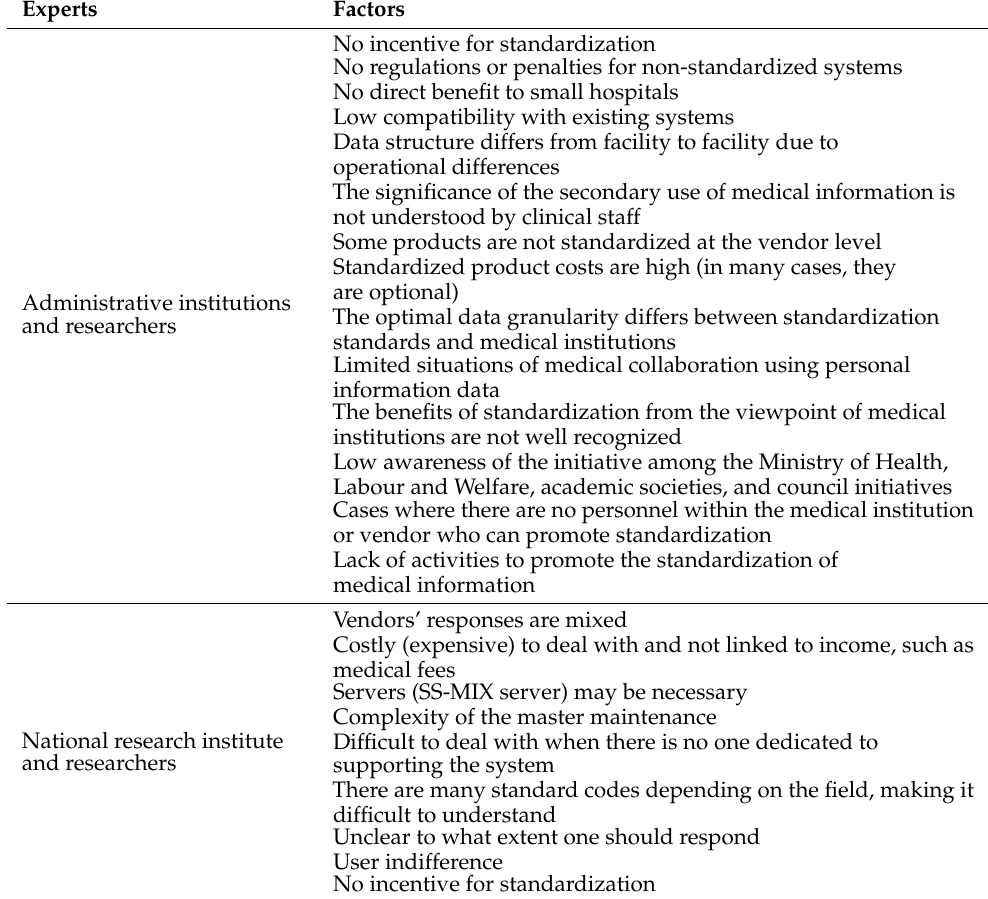
Table 1. Extracted factors